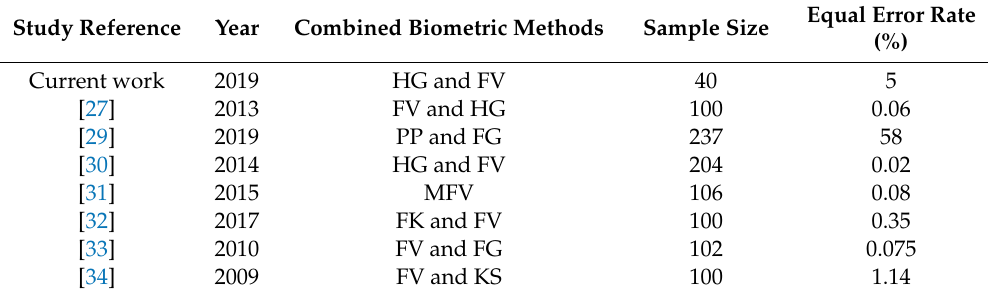
Table 1. Some multi-modal biometric studies from 2009 until